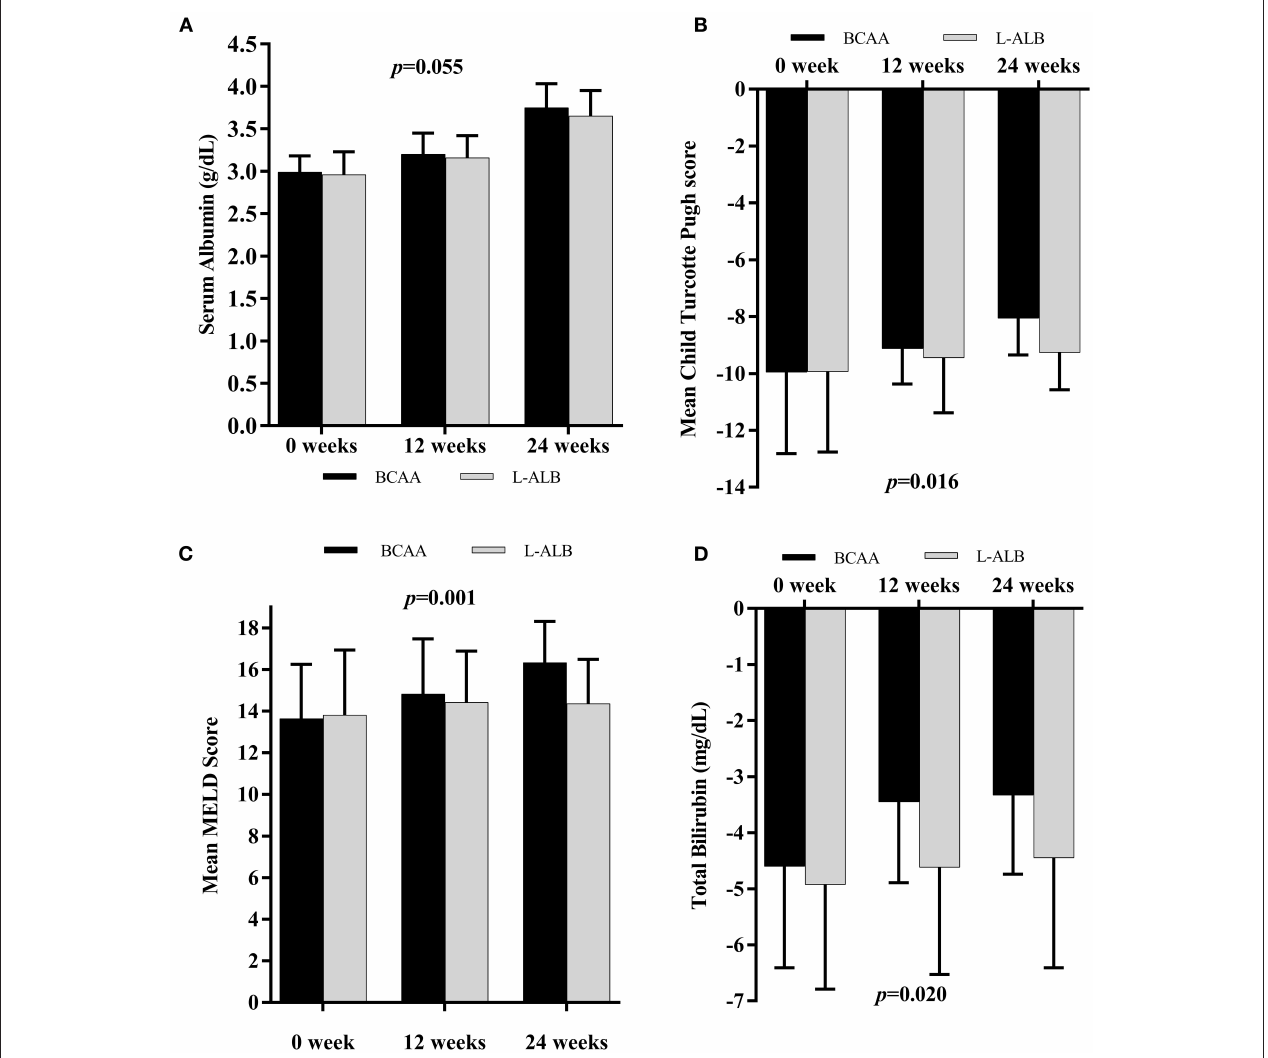
FIGURE 4 | Mean changes in Albumin concentration (A) , Child Turcotte Pugh score (B) , MELD score (C) , and Total Bilirubin level (D) in subjects supplemented with BCAA (black scale) or L-ALB (grayscale) over 24 weeks. MELD, Model for End-stage Liver Disease. Statistically significant at p <